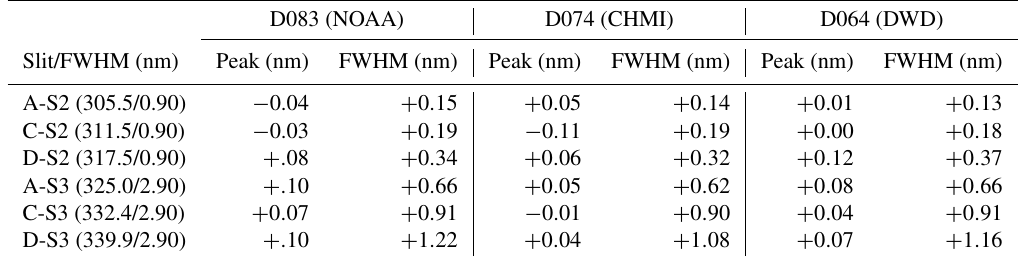
Table 2. Measured differences to Dobson’s specifications of wavelength settings and FWHMs; nominal values are given in the first column in brackets.